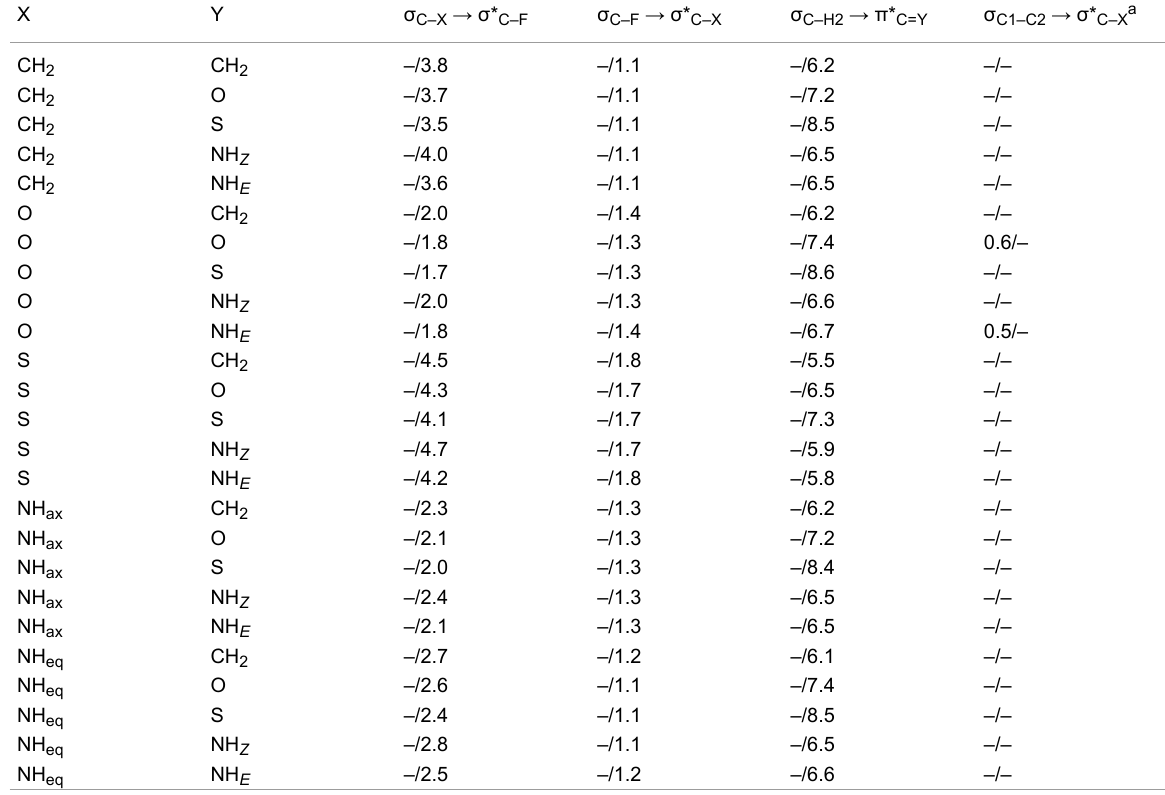
Table 3: Important antiperiplanar hyperconjugative interactions (given for axial/equatorial, in kcal mol − 1 ).